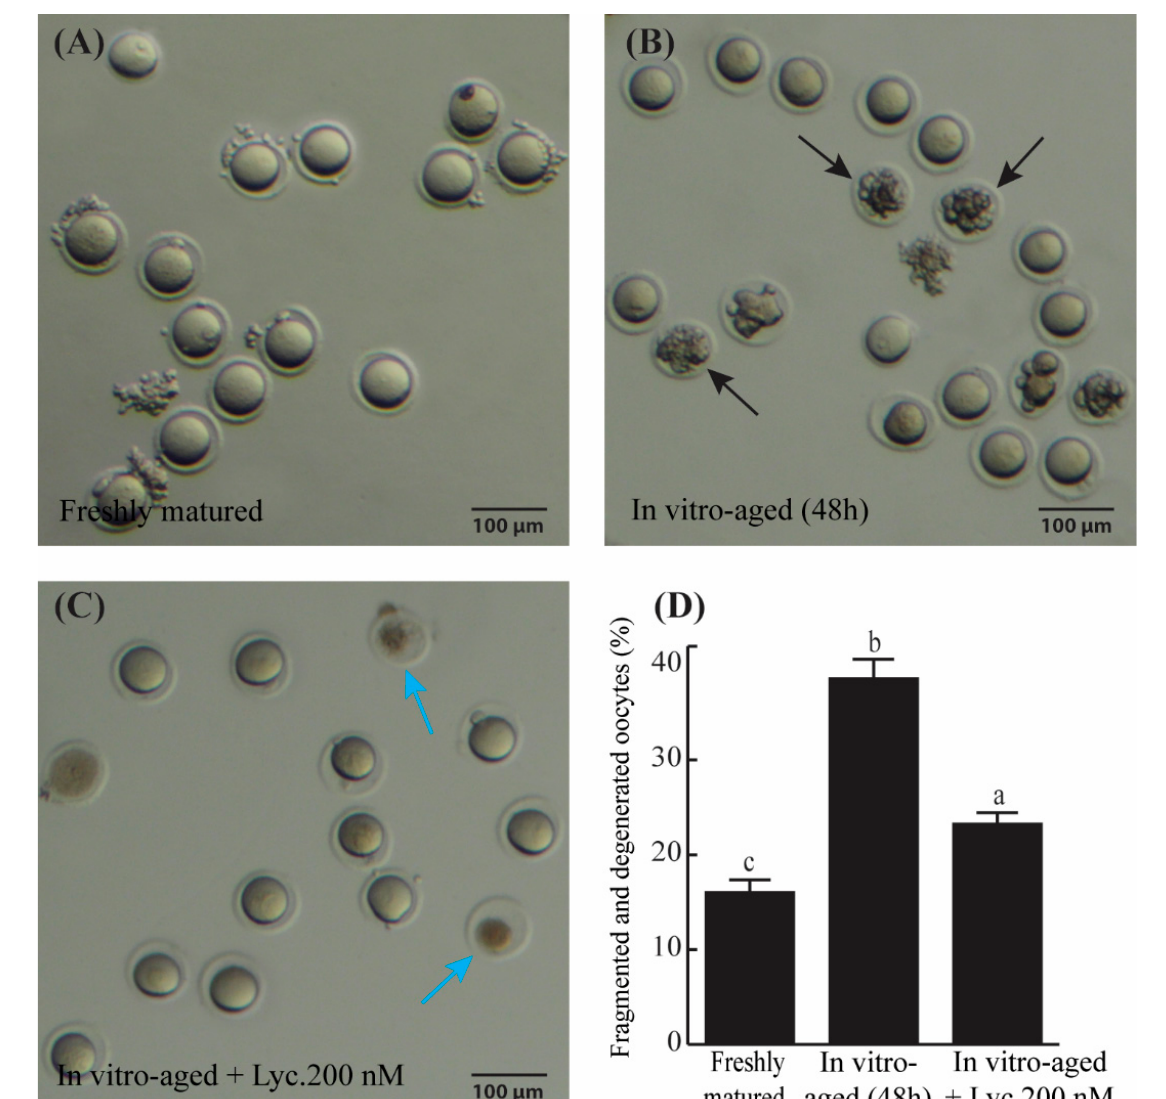
Figure 1. The rate of fragmented and degenerated oocytes in freshly matured, in vitro-aged, and in vitro-aged lycopene-treated groups. ( A – C ) Representative photomicrographs of freshly matured oocytes ( A ), in vitro-aged oocytes ( B ) (black arrows denote the fragmented oocytes), and in vitro-aged oocytes treated with 200 nM lycopene ( C) , (blue arrows refer to degenerated oocytes). ( D ) Quantitative comparison of the rate of oocyte fragmentation between freshly matured, in vitro-aged, and in vitro-aged lycopene-treated groups. Different superscripts indicate significant differences ( p < 0.05). Scale bars = 100 µm.